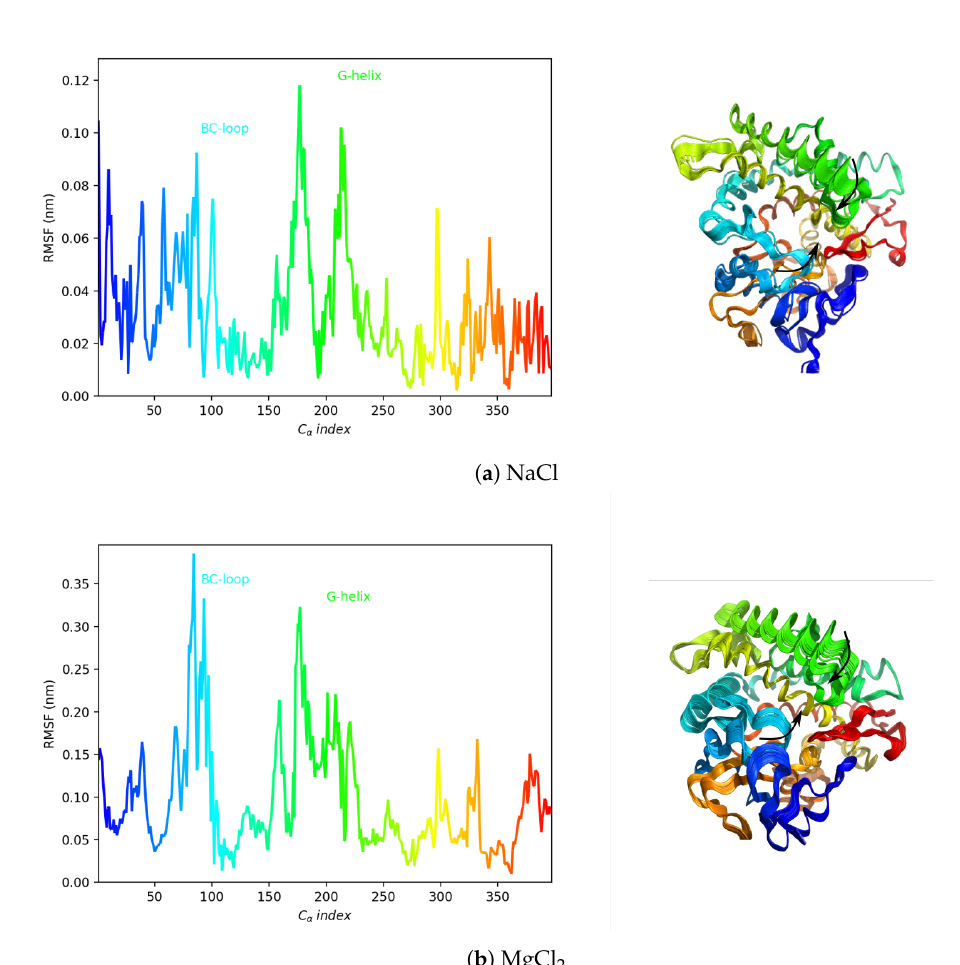
Figure 4. Root mean square fluctuations of the C α atoms of the trajectories (in NaCl and MgCl 2 buffer) projected on the first eigenvector. The C α indexing starts from 1 for the N-terminal residue ( left ). Fifty superimposed frames of the projected trajectory onto the first eigenvector. The black arrows indicate G-helix and BC-loop closure ( right ).